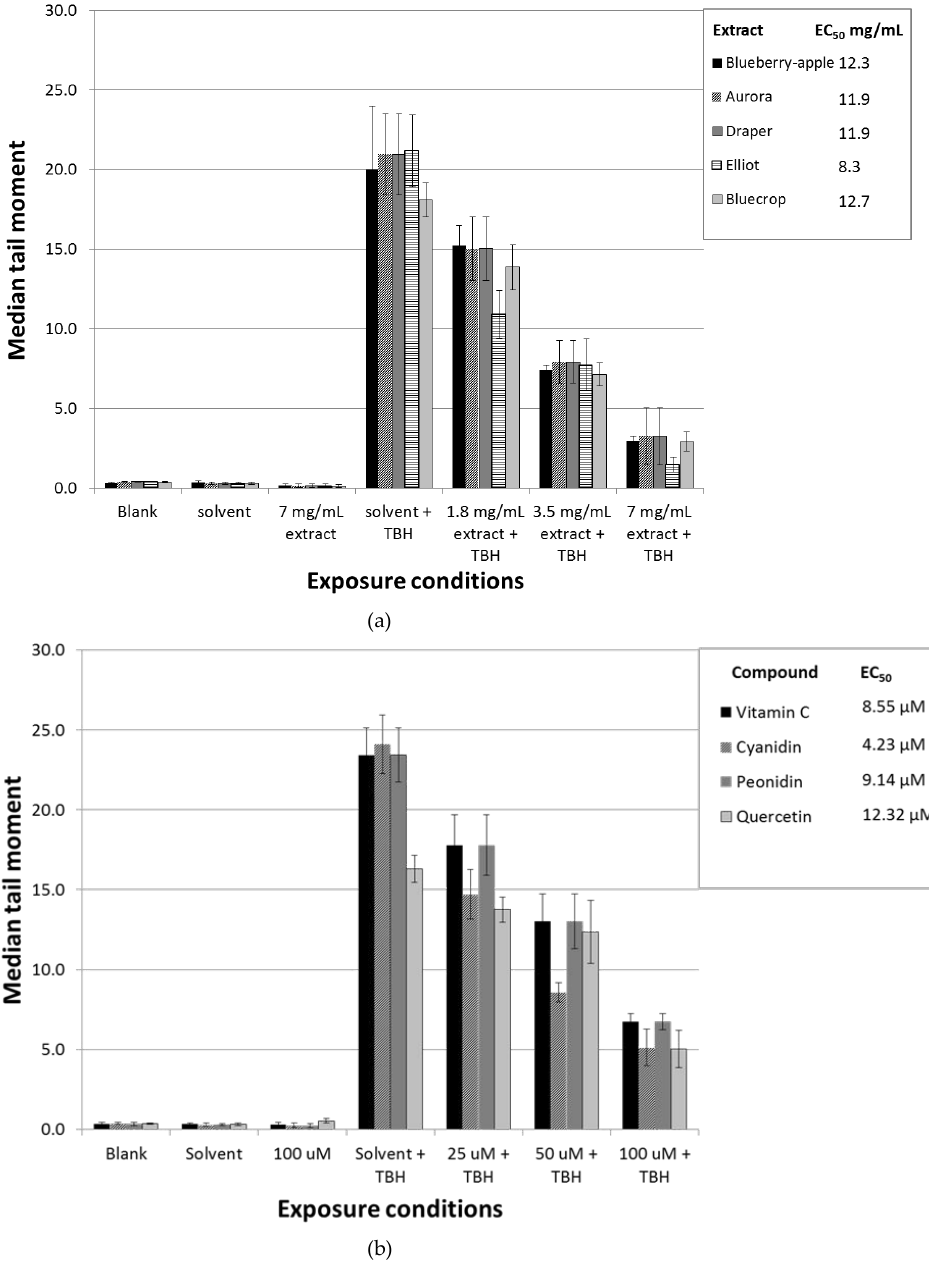
Figure 1. Level of DNA damage in Caco-2 cells as measured by the alkaline comet assay, expressed as average median tail moments. Error bars indicate standard deviations. Caco-2 cells were pre-incubated for 2 h with different concentrations of the extract of blueberry – apple juice or extracts of four different blueberry varieties ( a ), or single compounds ( b ) and subsequently exposed to 100 µM tert-butylhydroperoxide (TBH) for 1 h. Next, DNA strand breaks were measured using the alkaline comet assay. Pre-incubation for 2 h with medium, solvent control (0.5% end concentration of 70% methanol/0.1% formic acid), the highest concentration of the different extracts (i.e., 7 mg/mL), or 100 µM of single compounds did not induce any DNA damage. A dose-dependent decrease in DNA damage was observed for all blueberry extracts and single compounds tested (ANOVA, P < 0.01). In order to investigate which of the blueberry extracts and single compounds possessed the highest chemopreventive properties, linear log regression was applied. From the log linear regression equation, the EC 50 was estimated which is shown in the